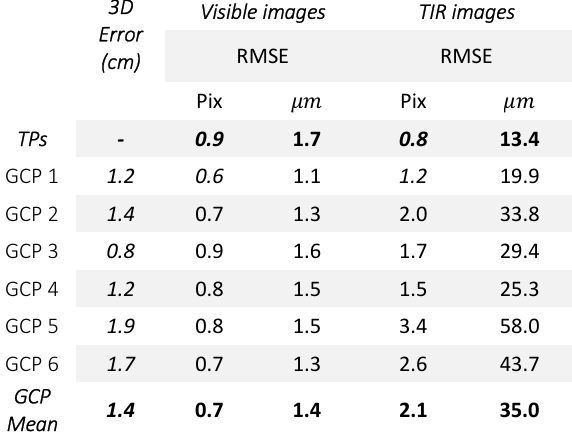
Table 3 Results of experiment #3 - jont adjustment of the visible and the TIR images with only GCPs used as tie